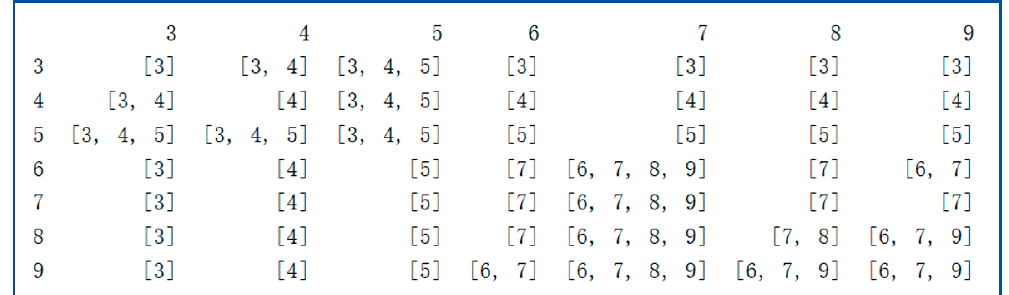
Figure 10. New top left (running result of Python).